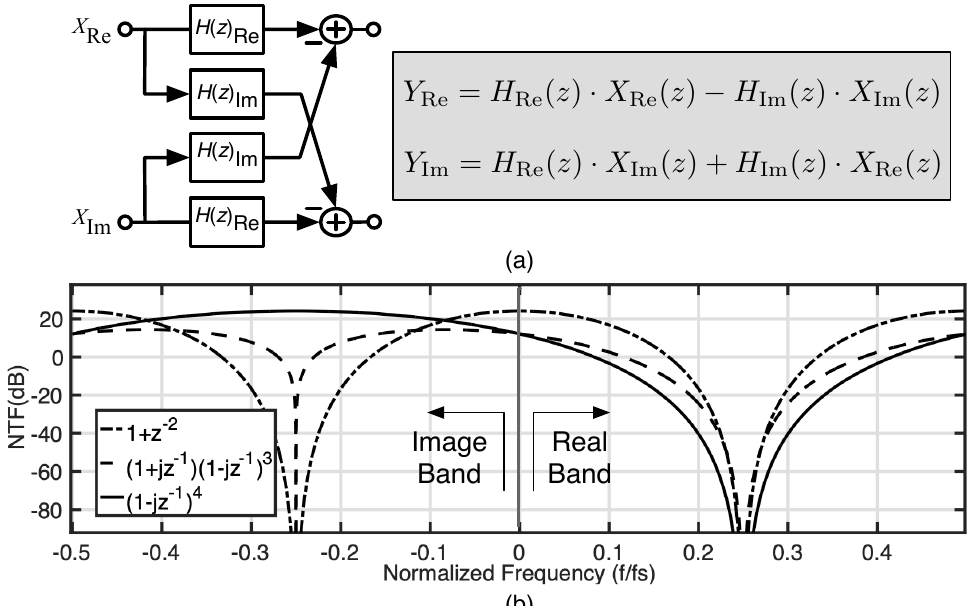
Figure 7. Quadrature BP- Σ∆ Ms. ( a ) Block diagram of a complex BP filter. ( b ) NTF with asymmetric placement of zeroes.